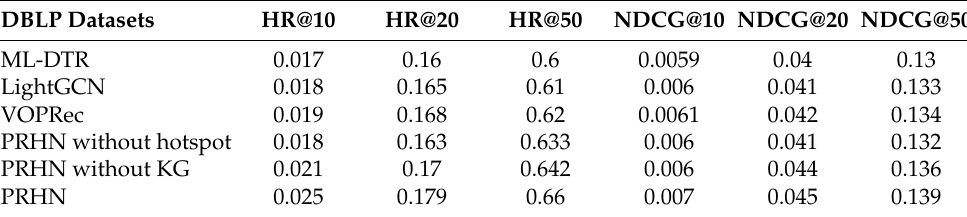
Table 3. Performance of different models on DBLP datasets. DBLP Datasets